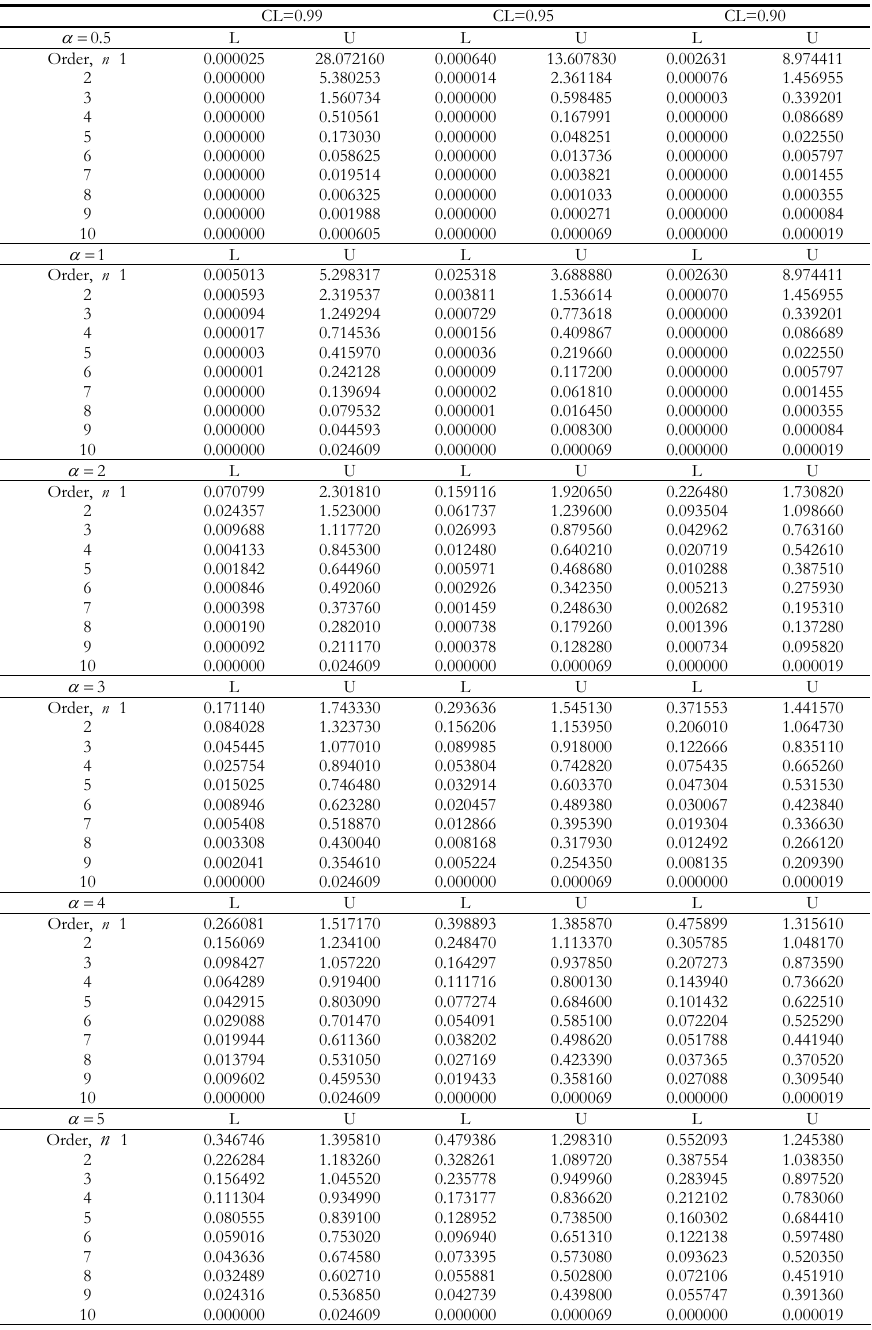
Confidence interval for n th lower record of Weibull